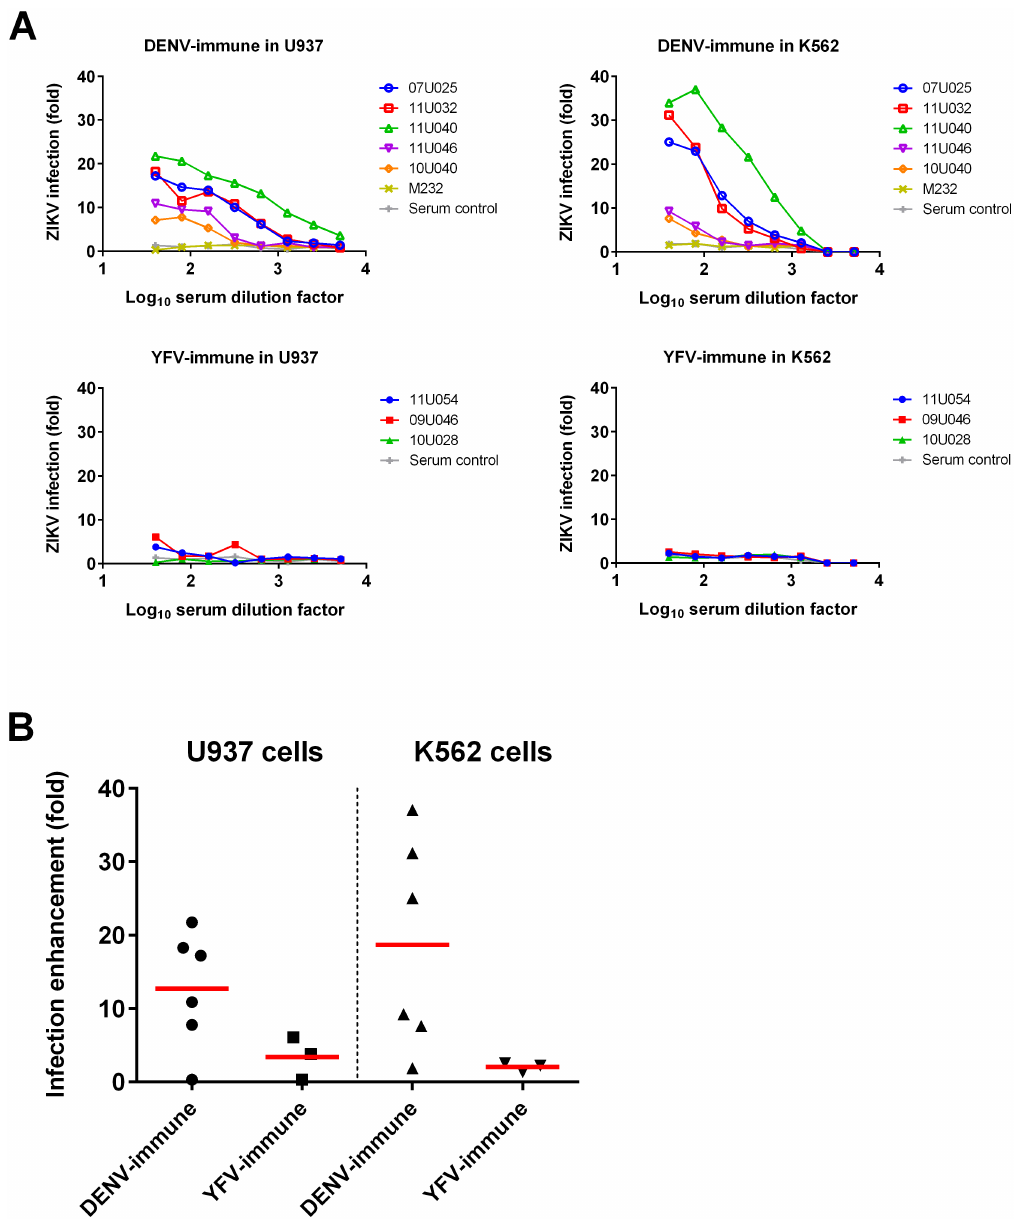
Fig 1. Antibody-dependent enhancement of ZIKV infection in vitro for day 0 sera. Antibody-dependent enhancement of infectionof U937 and K562 cells by ZIKV was assessedafter 24 hours using the flow cytometry based infectionassay. (A) Fold-enhancement curves for individual animals. Means of duplicatevalues are displayed. (B) Peak fold-enhancement values with the mean indicatedby a red bar. Serum control is from na ï vegroup animal 10U043.DENV-immune and YFV-immune sample sizes (n) for this analysisare 5 and 3,